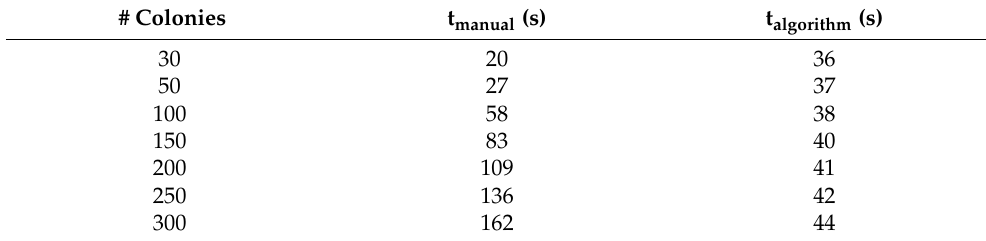
Table 5. Response time tests of the enumeration algorithm.